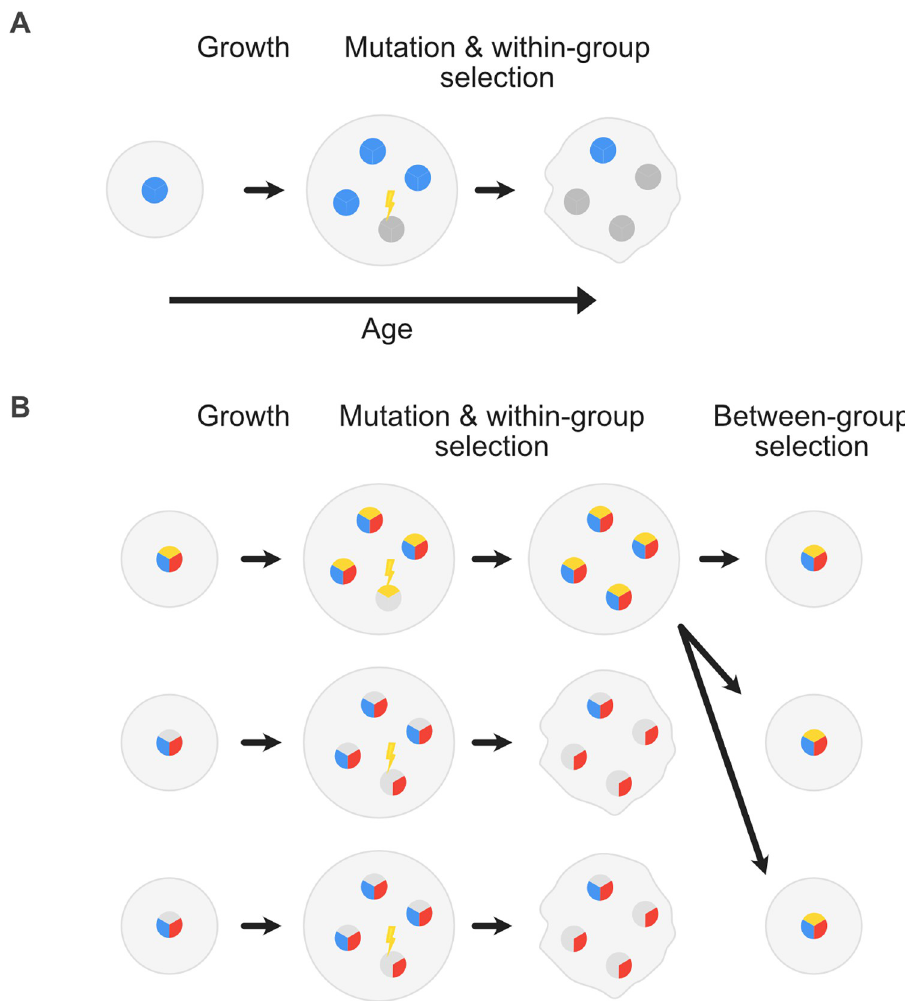
Fig 1. The problem of cooperation and the evolution of pleiotropy. (A) Mutation–selection dynamics can undermine clonal multicellular groups. Mutation of cooperative cells (blue) can generate noncooperative cells (dark grey) that do not pay the costs of cooperation but reap its rewards. These cheater lineages can spread within multicellular groups because they divide more rapidly than wild-type cells. Invasion of spontaneous mutant lineages can lead to a breakdown in group function (distorted shape). (B) Pleiotropy promotes cooperation in our model because it leads to between-group selection on the rate at which cooperation breaks down within groups as they age. Beginning with groups founded by 1 pleiotropic and 2 nonpleiotropic lineages, we see that groups founded by the nonpleiotropy lineages loose function and are eventually replaced by the pleiotropic lineage. Cells are coloured in 3 parts according to whether they display cooperation (blue), a privately beneficial trait (red), and pleiotropy (yellow), whereby the cooperative and private traits are linked. Mutations can make some traits inactive (grey). When cooperation is lost in a pleiotropic cell lineage (top row), the cells also lose their private trait, which stops them from proliferating. Group function is thereby preserved. When cooperation is lost in a nonpleiotropic lineage (second row), cheater lineages emerge that spread and group function is lost. As a result, pleiotropic groups thrive relative to nonpleiotropic ones and seed more groups, giving rise to between-group selection for pleiotropy.